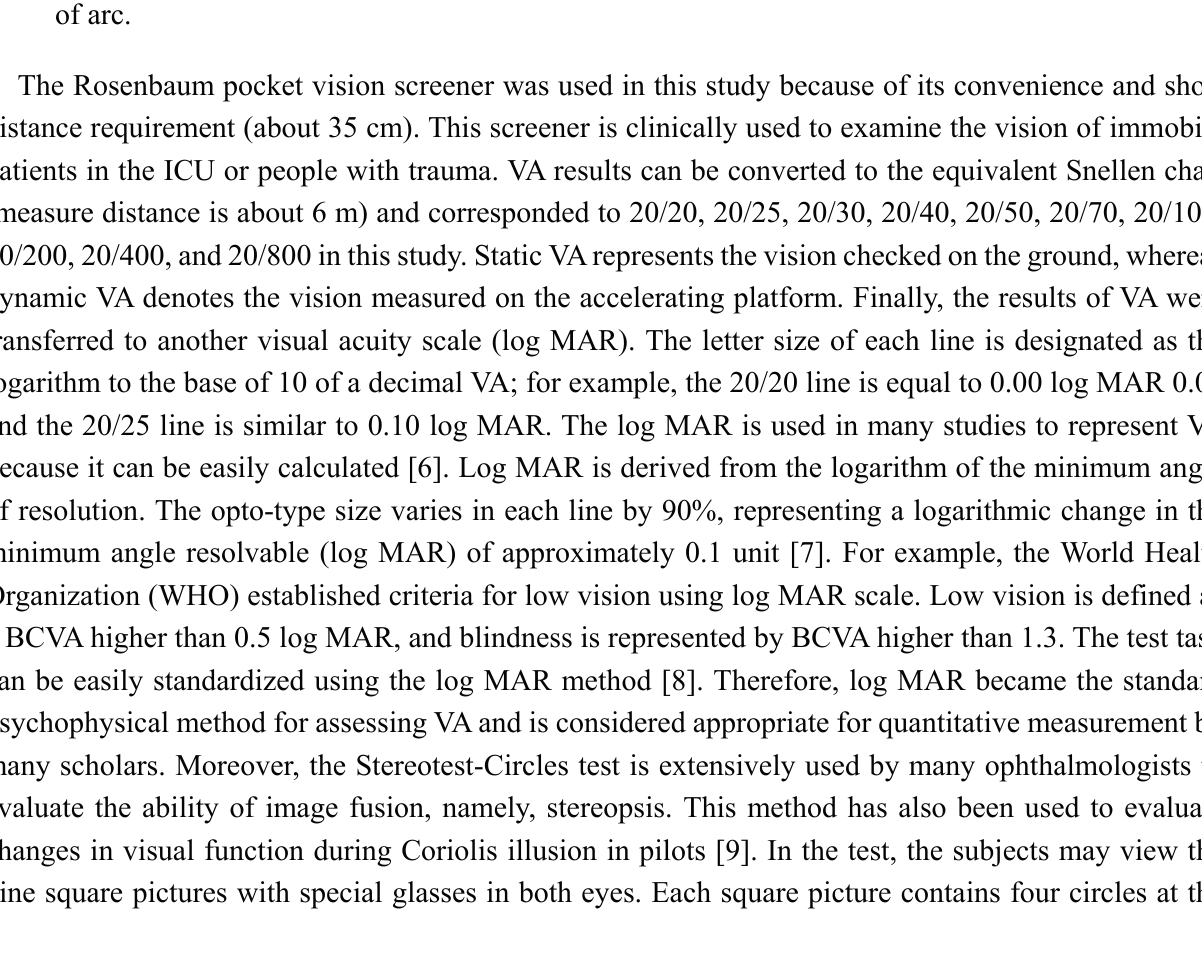
Figure 4. Stereopsis was tested using the picture card of Stereotest-circles (this card contains a total of nine square pictures and only one circle was presented as “forward” to the participants in each square. In this test, all subjects should wear special glasses and determine if the forward phenomenon persisted or not). The unit of stereopsis is shown as second (s) of